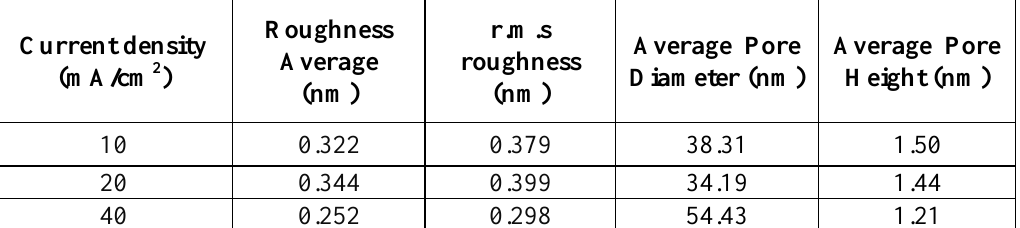
Table 2: The calculated morphology characteristics of p-PS samples prepared at different etching current densities.